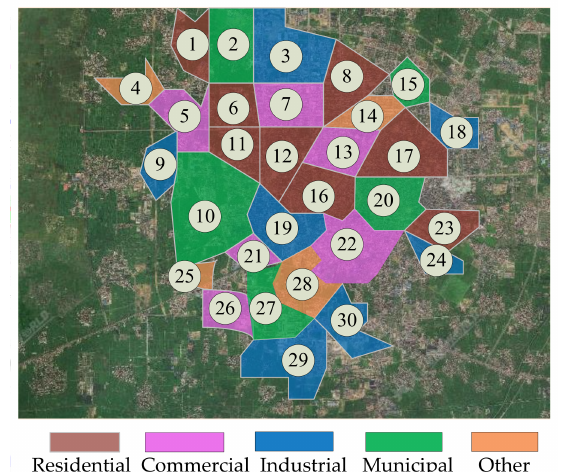
Figure 4. The planning map of a typical new urban district in Northern China.